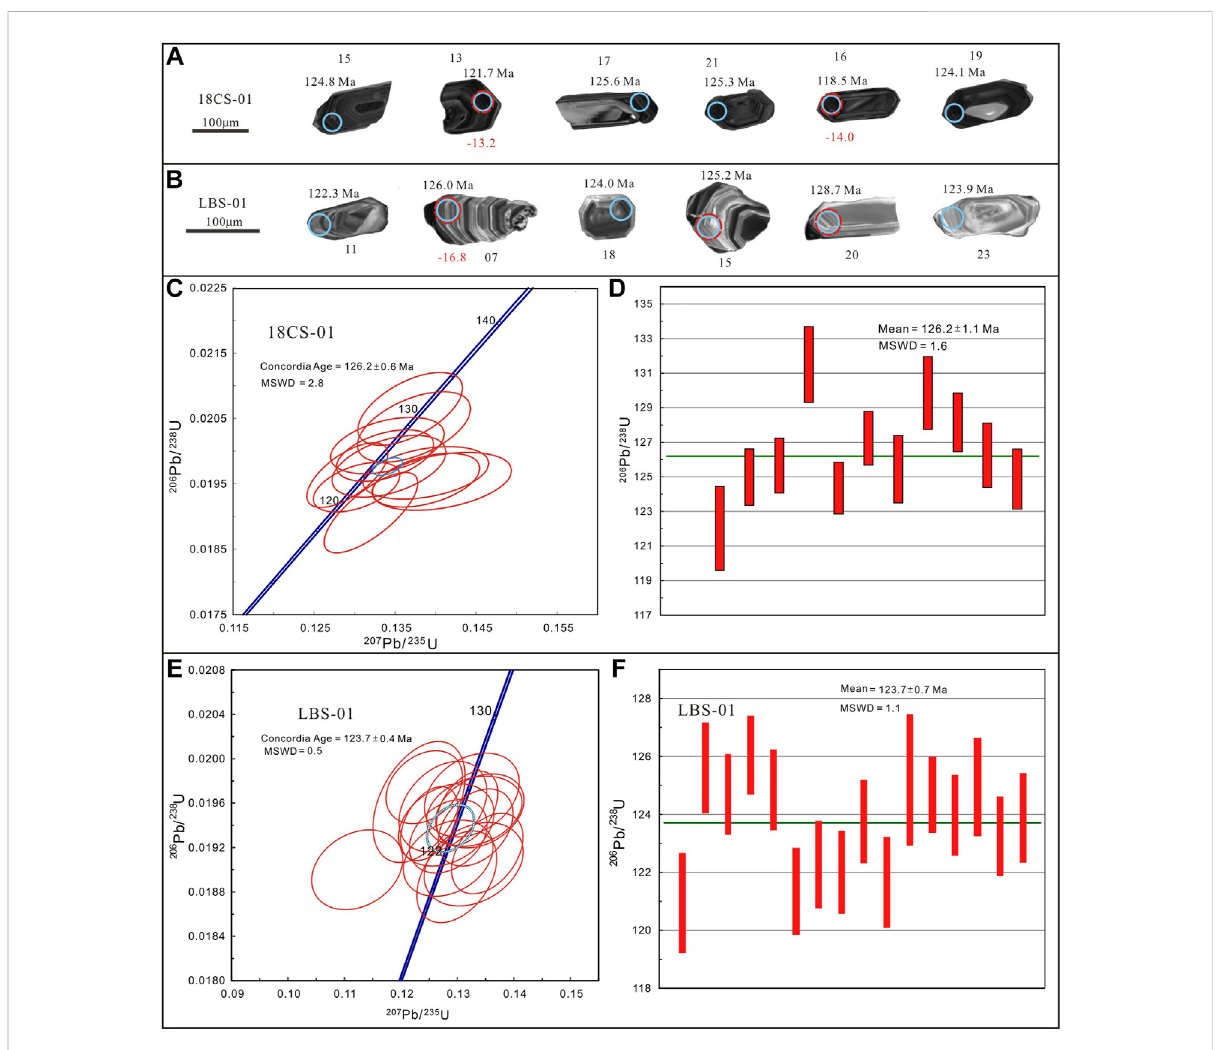
FIGURE 3 (A,B) Cathodoluminescence(CL)imagesofrepresentativezircongrainsinsample18CS-01andLBS-01,showinganalyticalpositions, 206 Pb/ 238 U ages, and ε Hf (t) values. (C – F) U-Pb concordia diagram and weighted mean 206 Pb/ 238 U ages of zircons from Chishan and Longbaoshan